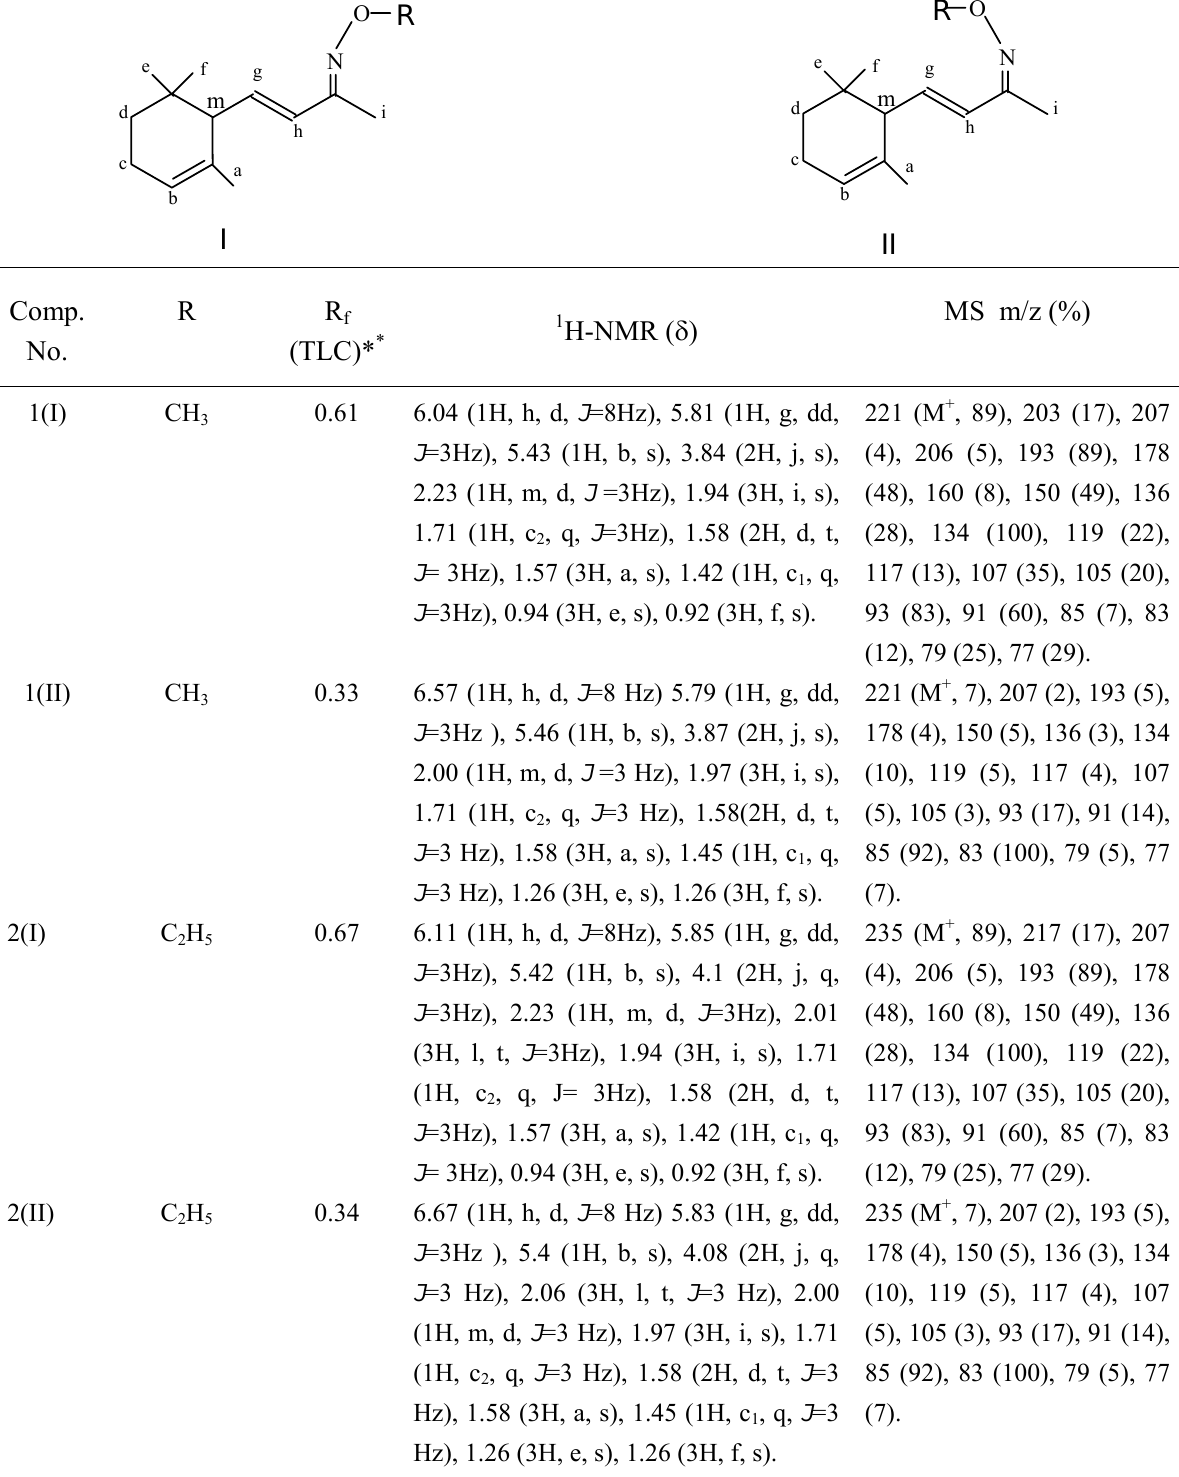
Table 2. 1 H-NMR and mass spectral data of 4'-(2,6,6-trimethyl-2-cyclohexen-1-yl)-3'- buten-2'-ketoxime-N-O-alkyl